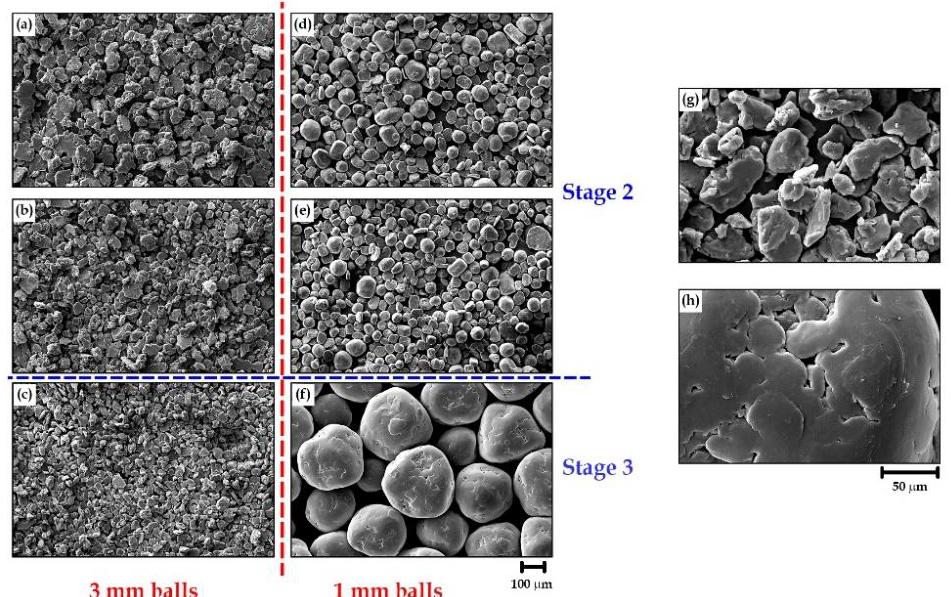
Figure 4. Scanning electron micrographs (secondary electrons) showing the resulting morphologies following the second and third stages of milling with 3 and 1 mm balls. ( a ) M2, ( b ) M3, ( c ) M6, ( d ) M4, ( e ) M5 and ( f ) M7. ( g ) and ( h ) are enlargements of those in ( c ) and ( f ), respectively (see Table 1).